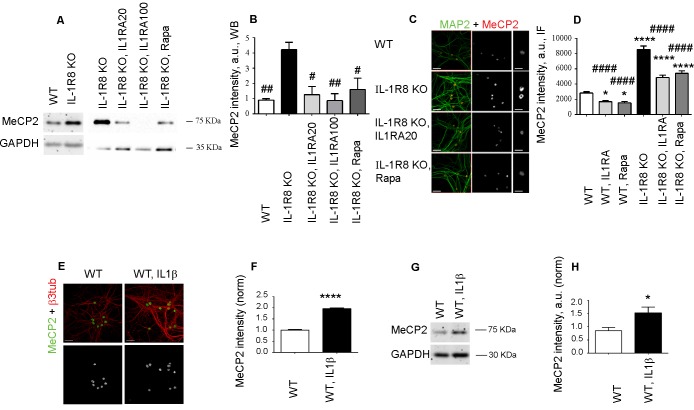
IL-1R8 KO neurons display higher MeCP2 levels that are responsible for LTP defects in IL-1R8 KO neurons.(A) MeCP2 expression analyzed by western blotting in cultured neurons from WT or IL-1R8 KO neurons treated or not with IL-1Ra (20 ng/ml), IL-1Ra (100 ng/ml) or Rapa (20 nM). A higher MeCP2 expression is detectable in IL-1R8 KO neurons, which is reduced by IL-1Ra or Rapa. (B) Quantitative analysis of MeCP2 expression. Number of replicates: 3 (WT), 3 (IL-1R8 KO), 3 (IL-1R8 KO, IL1Ra 20), 3 (IL-1R8 KO, IL1Ra 100), 3 (IL-1R8 KO, Rapa); one-way ANOVA analysis of variance followed by post hoc Tukey test. (C) MeCP2 and MAP2 immunocytochemical staining of 16 DIV hippocampal WT or IL-1R8 KO neurons treated overnight (14 hr) with vehicle, IL1Ra (20 ng/ml) or Rapa (20 nM). Scale bar, 40 μm (low magnification image), 20 μm (insert). (D) Quantitative analysis of MeCP2 immunoreactivity in neurons treated as above. Number of analyzed neurons: 88 (WT), 60 (WT, IL1Ra), 55 (WT, Rapa), 52 (IL-1R8 KO), 66 (IL-1R8 KO, IL1Ra), 81 (IL-1R8 KO, Rapa); one-way ANOVA analysis of variance followed by post hoc Tukey test. (E) Immunocytochemical staining for MeCP2 and β3-tubulin of 16 DIV WT hippocampal neurons, exposed or not to IL1β (40 ng/ml) overnight. Scale bar, 40 μm. (F) Quantitative analysis of MeCP2 immunoreactivity reveals higher MeCP2 levels in IL1β treated neurons. Number of analyzed neurons: 288 (WT), 227 (WT, IL1β); Student t test. (G and H) Representative western blotting (G) and quantitative analysis (H) of MeCP2 expression in WT neurons treated with IL-1β (40 ng/ml). Number of replicates, WT: n = 5; WT + IL1β 40: n = 5 independent experiments. Mann Whitney test. * indicates significance compared to WT, # indicates significance compared to IL-1R8 KO.